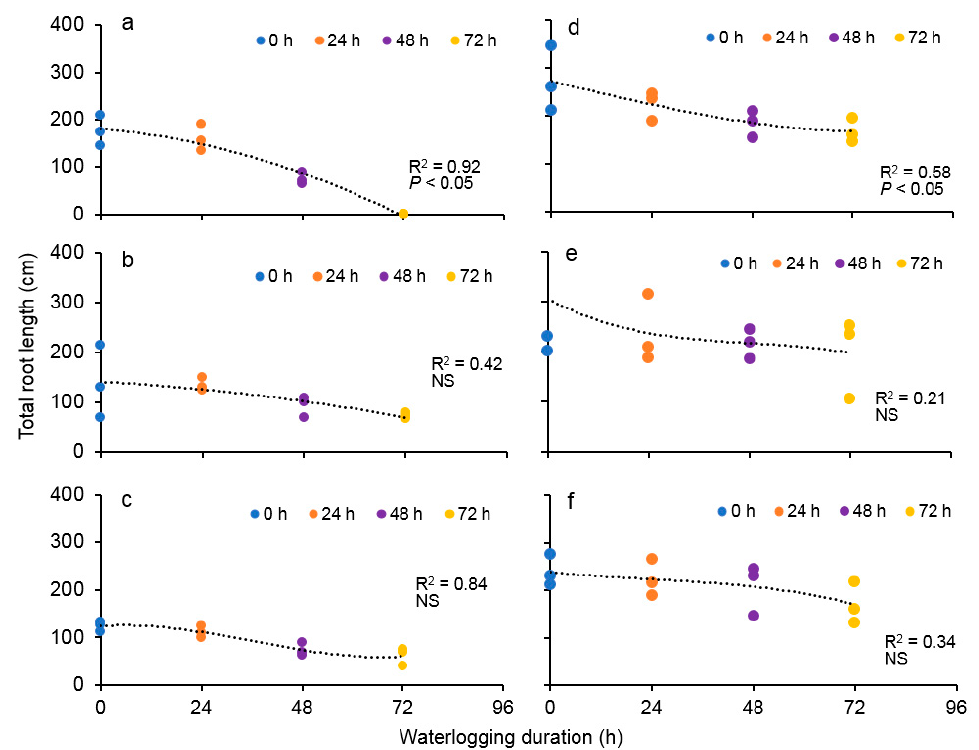
Figure 5. Effect of waterlogging duration on sunflower total root length for early sowing ( a ) emer- gence, ( b ) 2-leaf stage and ( c ) 4-leaf stage, and for late sowing ( d ) just after sowing, ( e ) 2-leaf stage and ( f ) 4-leaf stage. Each value is the mean of three replications.